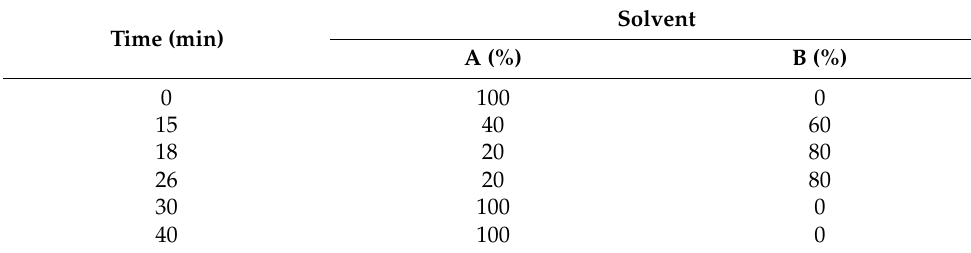
Table 3. The solvent gradient program for the analysis of dopamine levels. Time